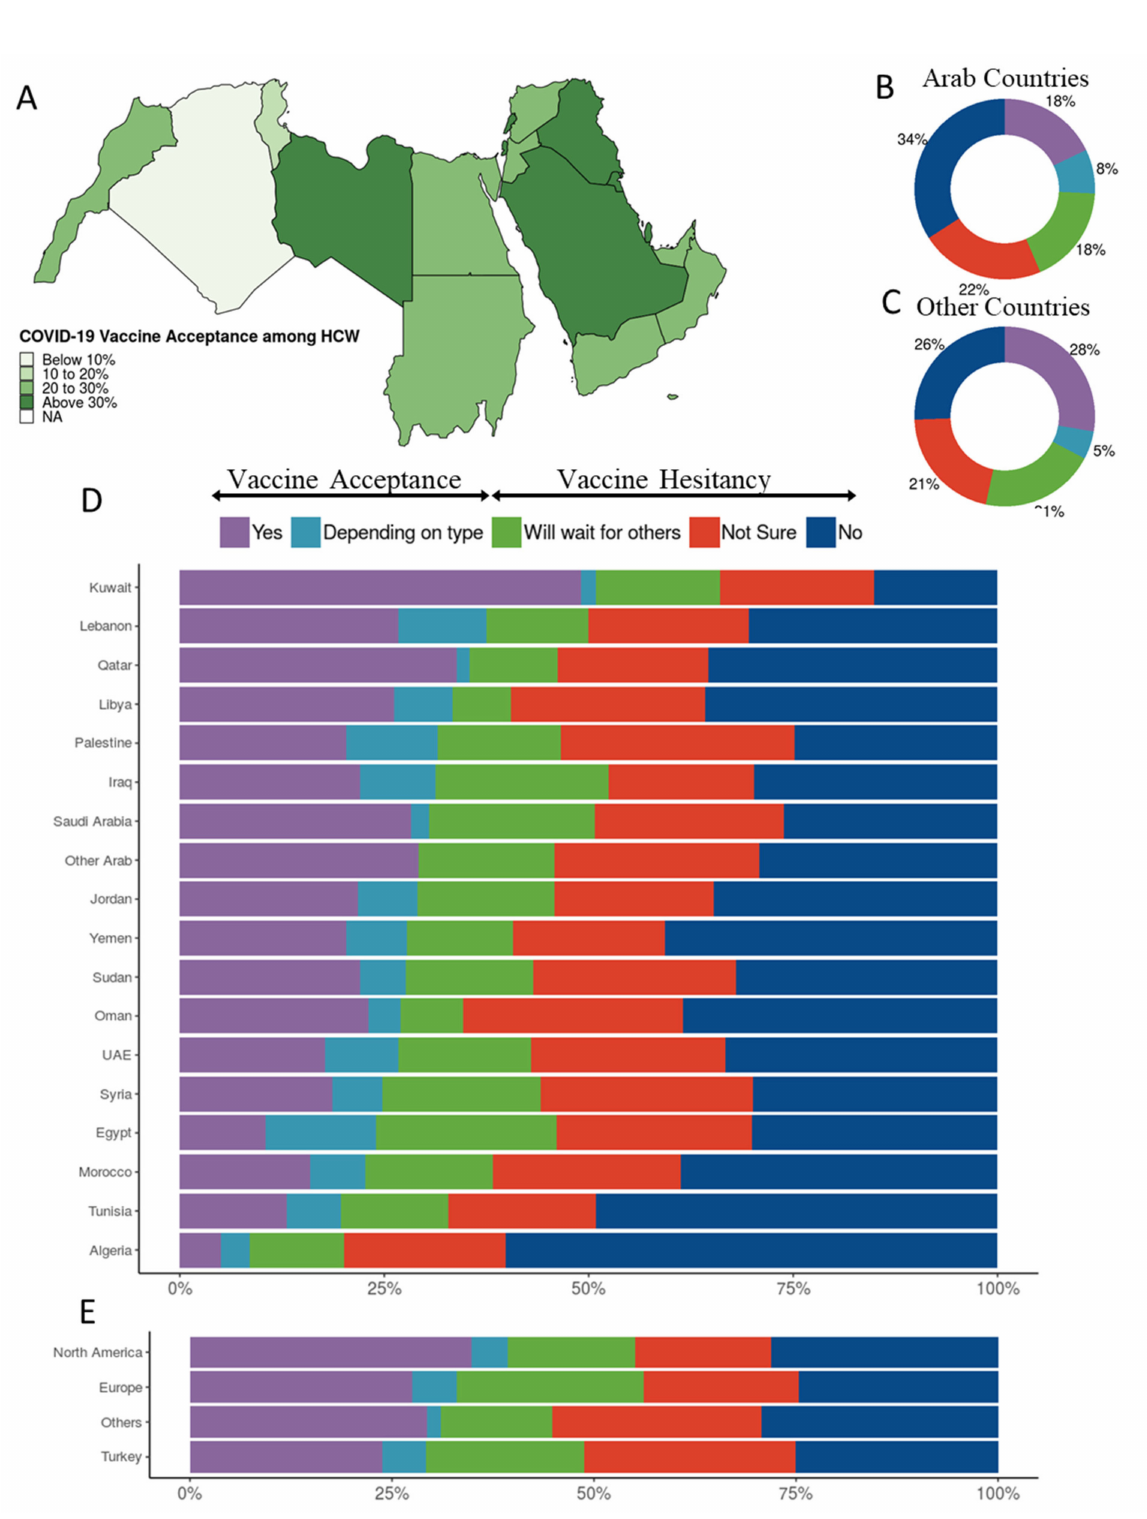
Figure 1. COVID-19 vaccination attitudes among 5708 HCW participants. ( A ) Vaccine acceptance per country in the Arab region, ( B ) vaccination attitudes reported by HCWs from Arab countries and territories, ( C ) vaccination attitudes reported by HCWs from countries other than Arab countries and territories, ( D ) vaccination attitudes reported by HCWs per Arab country/territory, and( E ) vaccination attitudes reported by HCWs from countries other than Arab countries and territories clustered by residency